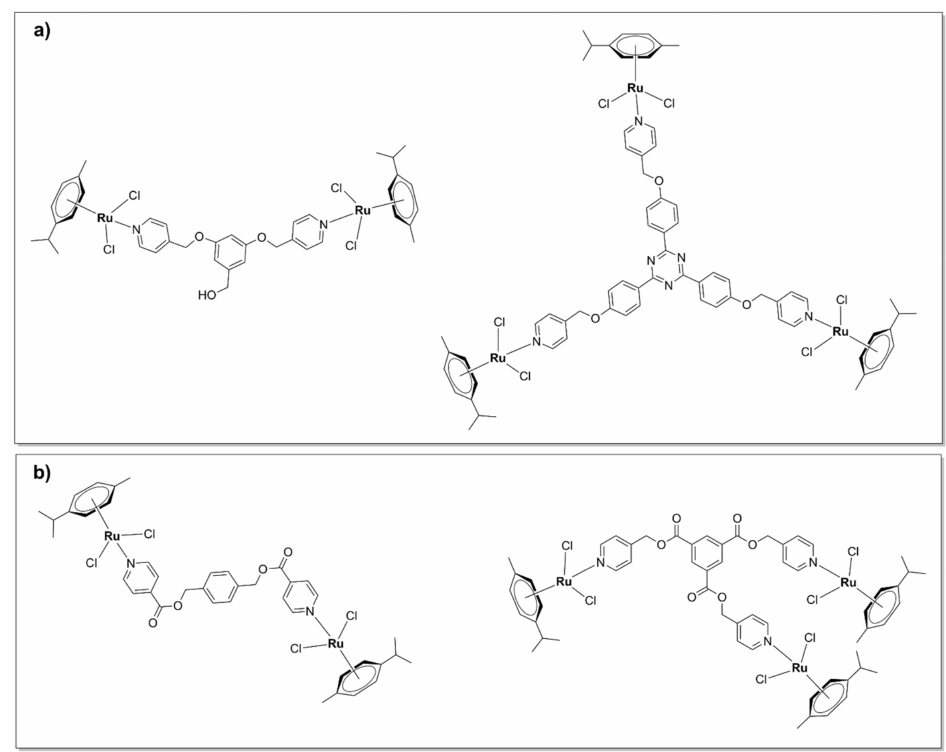
Figure 23. Di- and tri- nuclear Ru(II)- η 6 - p -cymene complexes in which the ruthenium centers are bridged by ( a ) pyridyl aromatic ether ligands and ( b ) pyridyl aromatic ester ligands.